Question: Which kind of chart has been used to present this data?
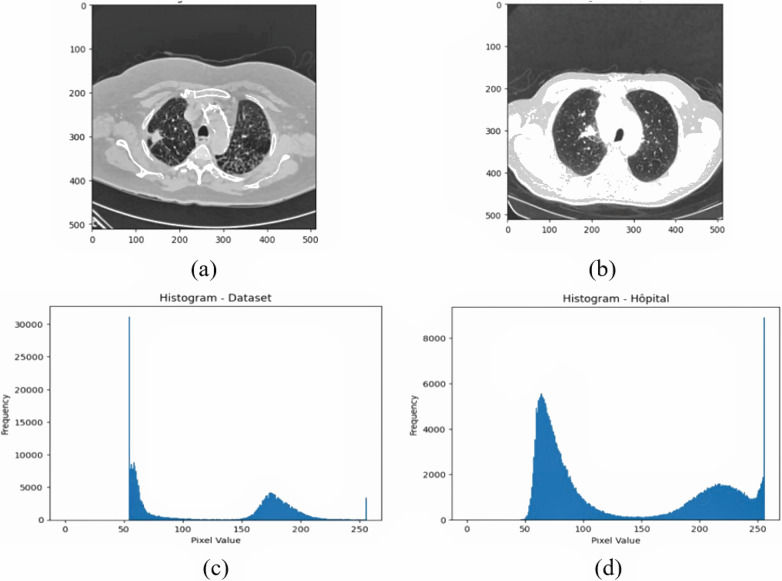
Answer: histogram